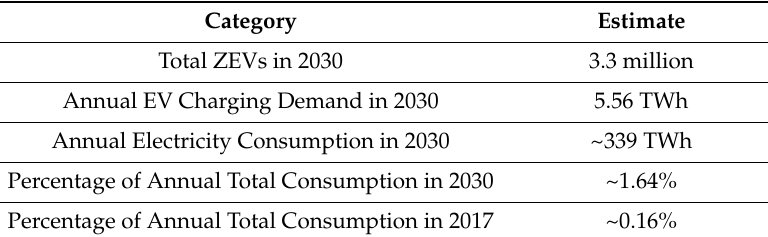
Table 11. Total Annual Charging Demand in 2030—Mid Scenario.